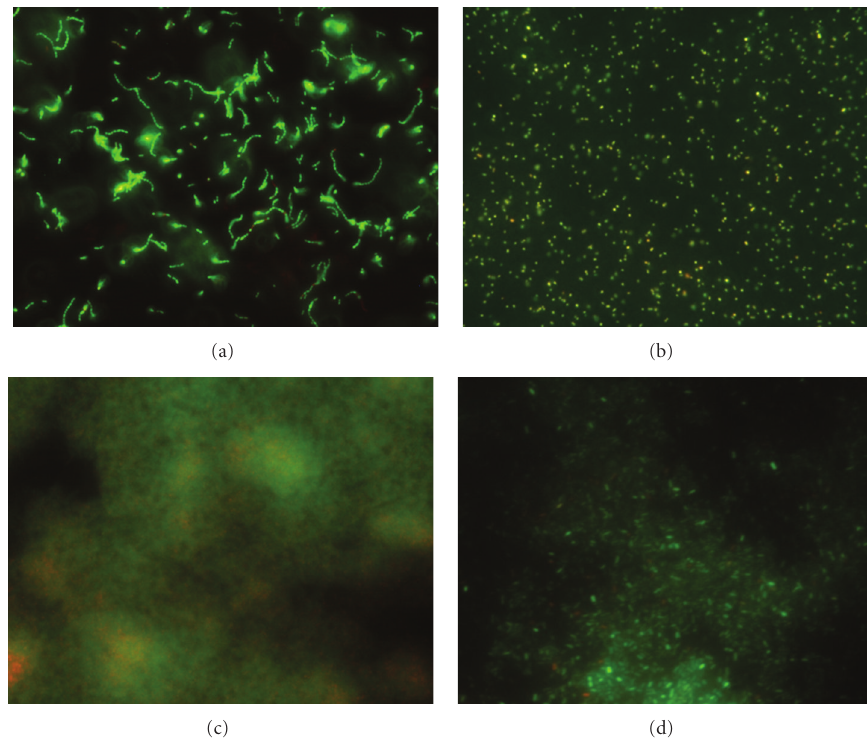
Figure 3: Epifluorescent optical microscopy of SWCNTs CSs colonized by Streptococcus mutans. ATCC 25175 T and Pseudomonas aeruginosa ATCC 15692 S. mutans (a) and P. aeruginosa (b) adherent bacteria on SWCNTs CSs after 3 hours of incubation; S. mutans (c) and P. aeruginosa (d) biofilm on SWCNTs CSs after 24 hours of